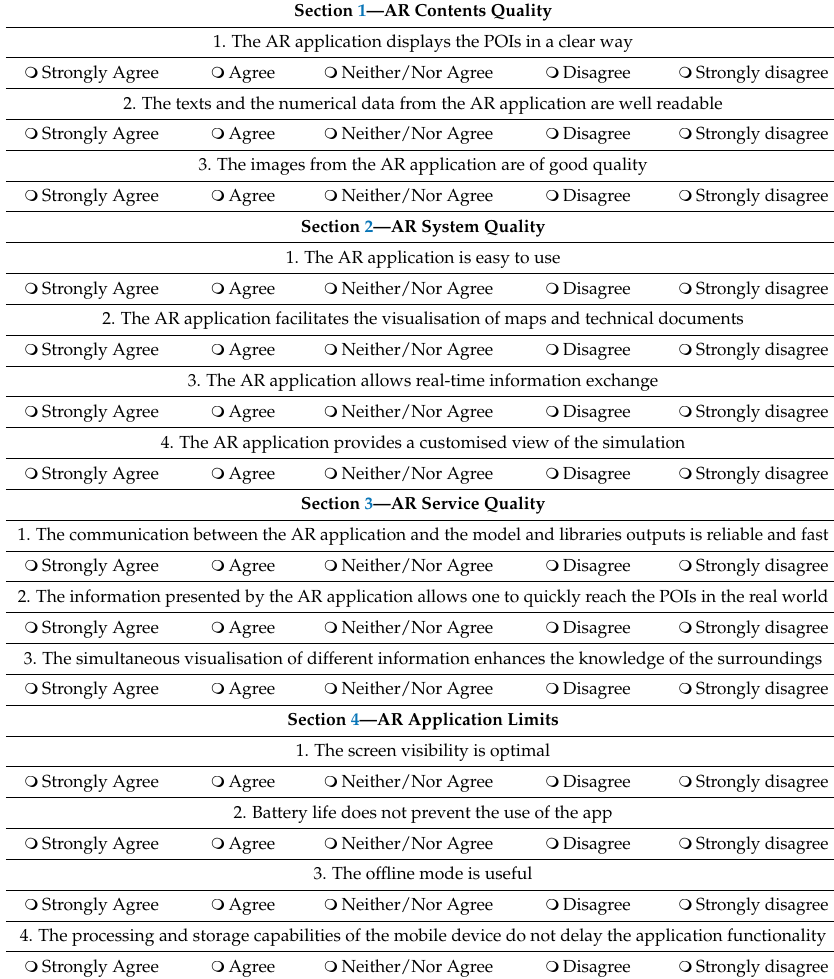
Table 2. The questionnaire distributed after the tests.